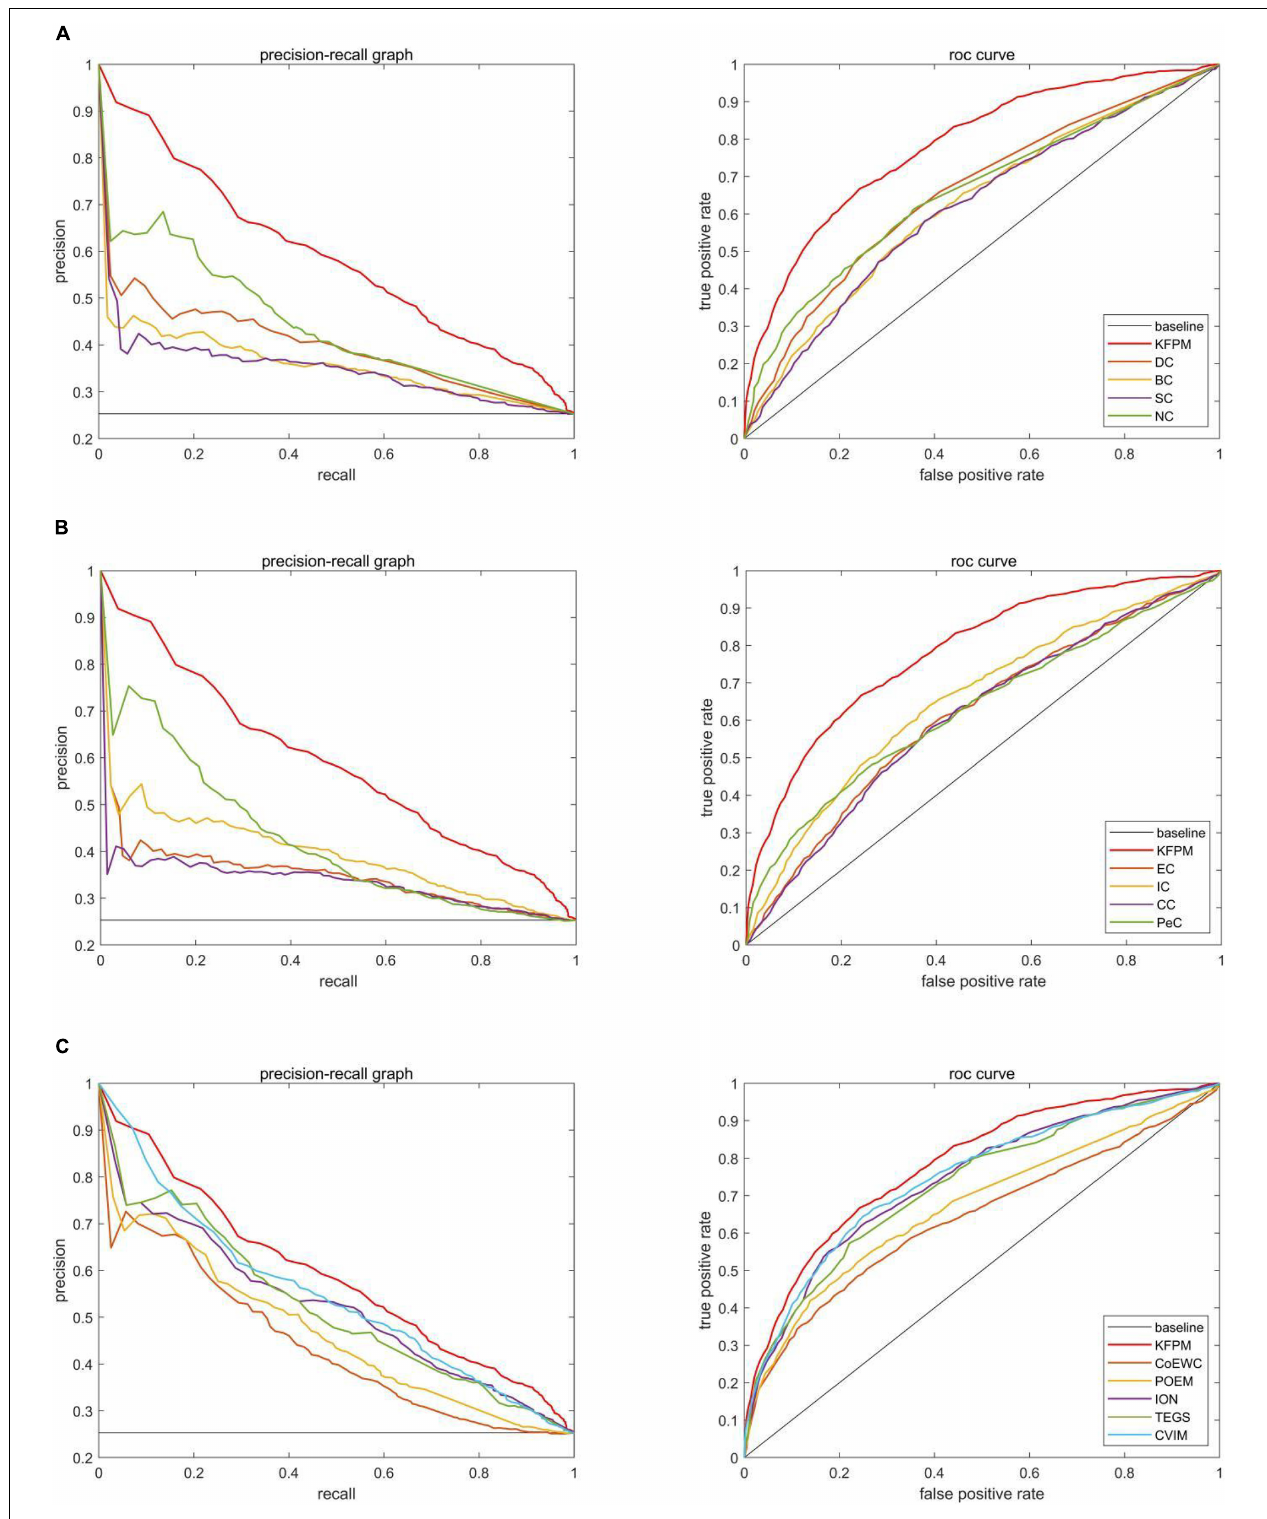
FIGURE 8 | Comparison of PR curves and ROC curves between KFPM and 13 competing methods based on the Krogan database. (A) PR curves and the ROC curves of DC, BC, SC, and NC. (B) PR curves and ROC curves of EC, IC, CC, and Pec. (C) PR curves and ROC curves of CoEWC, POEM, ION, TEGS, and CVIM.